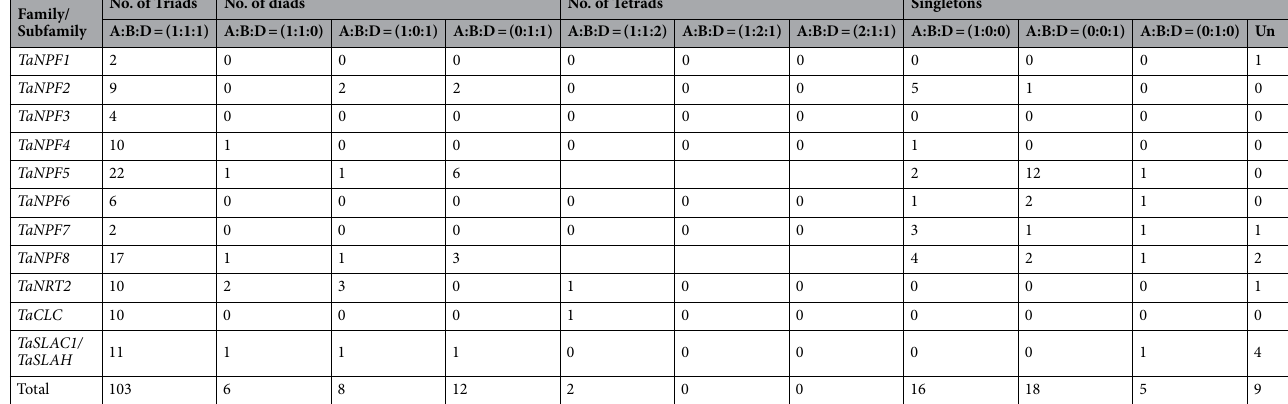
Table 3. Number of triads, tetrads, diads and singletons detected in nitrate transporter families in hexaploid wheat genome.